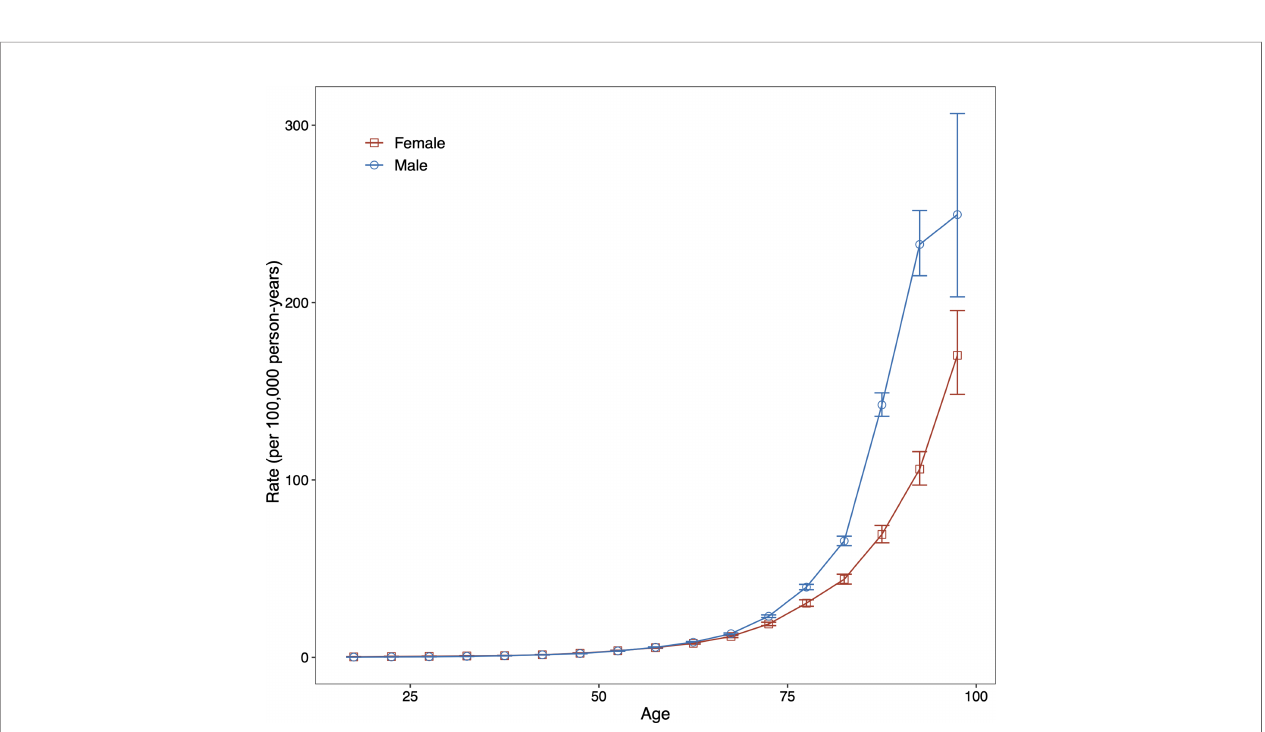
FIGURE 2 | Local drifts with net drift values for males and females for type 2 diabetic kidney disease (DKD) mortality in China from 1990 to 2019. The horizontal solid lines are the net drifts, and the dashed lines showed their 95% con fi dence intervals. The solid line of the curve are the local drifts and the shaded area indicate their 95% con fi dence intervals. DKD, type 2 diabetic kidney disease.